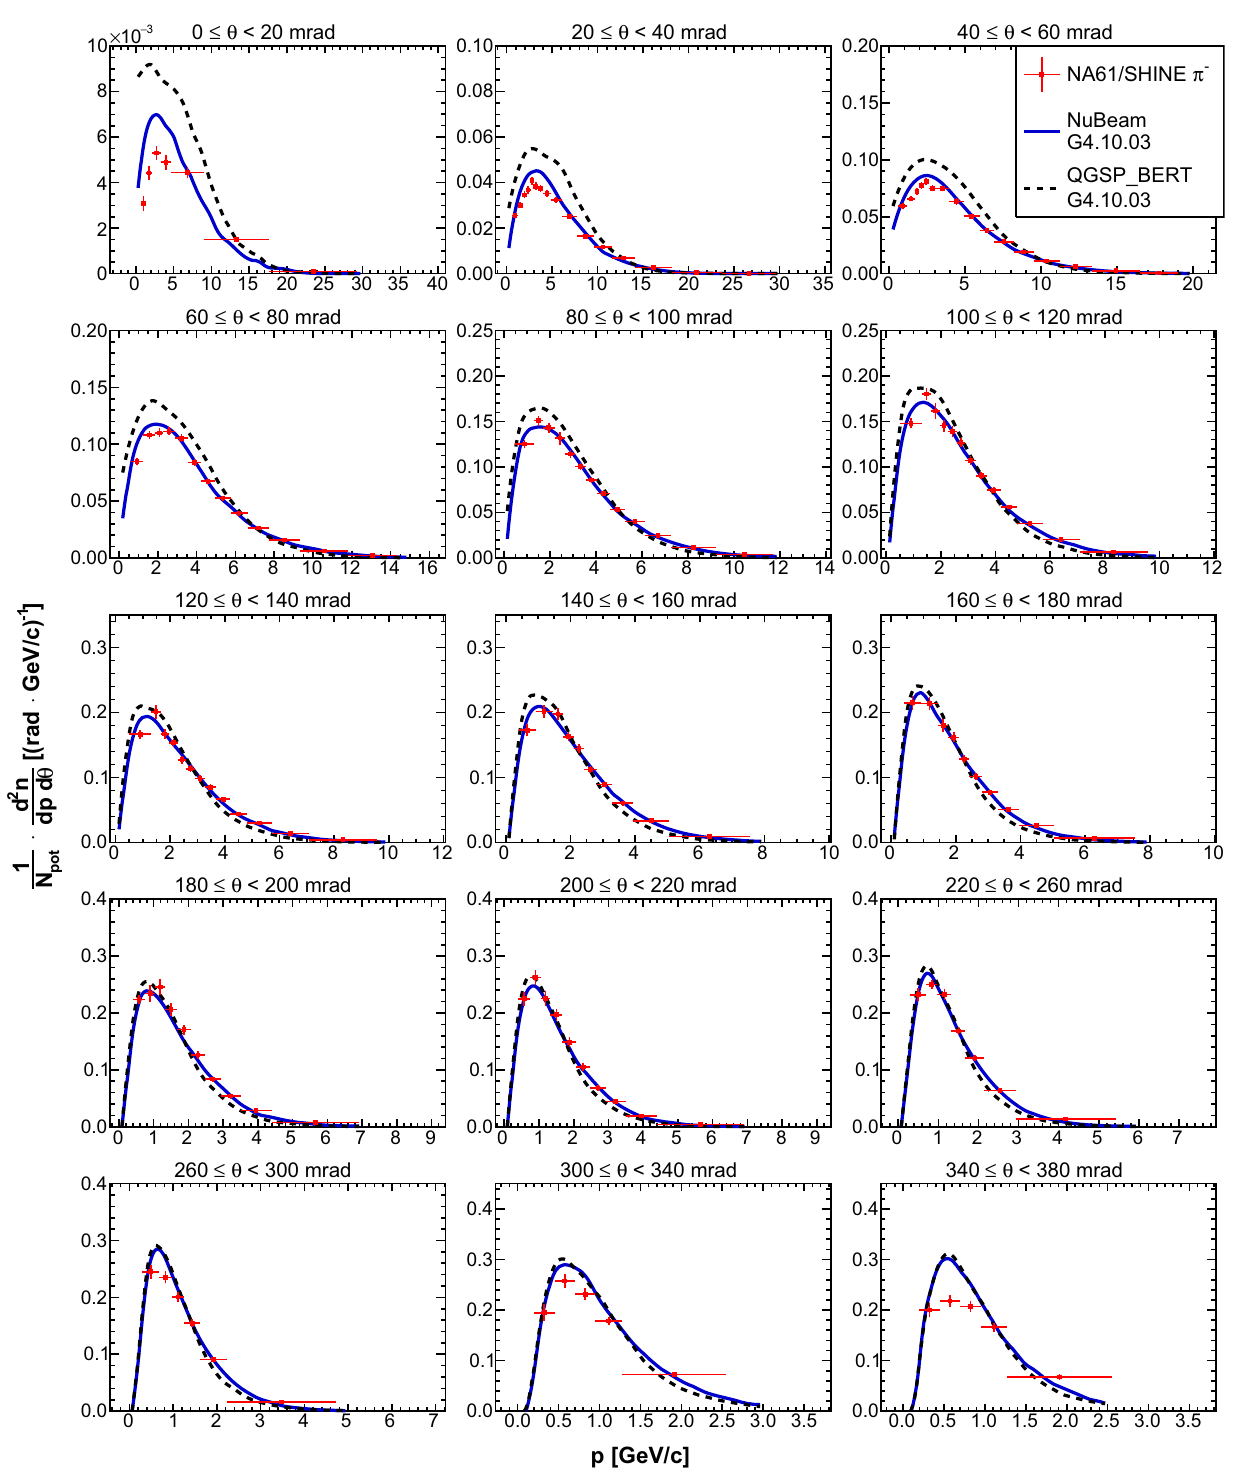
Fig. 33 Double differential yields of negatively charged pions for the fifthupstreamlongitudinalbin(72 ≤ z < 90cm).Verticalbarsrepresent the total uncertanties. Predictions from the NuBeam (solid blue line)